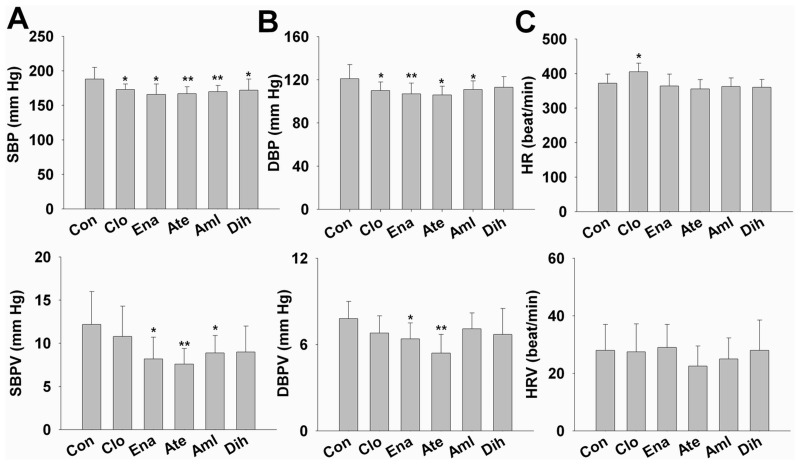
Effects of 3-month treatment of 5 different antihypertensive drugs on the hemodynamics in SHR.(A) SBP and SBPV. (B) DBP and DBPV. (C) HR and HRV. Data are presented as mean ± SD and analysized by ANOVA followed by dunnett t-testing. *P<0.05, **P<0.01 vs. control. Abbreviation: Con, control; Clo, clonidine; Ena, enalapril; Ate, atenolol; Aml, amlodipine; Dih, dihydrochlorothiazide; SBP, systolic blood pressure; DBP, diastolic blood pressure; SBPV, systolic blood pressure variability; DBPV, diastolic blood pressure variability; HR, heart rate; HRV, heart rate variability.